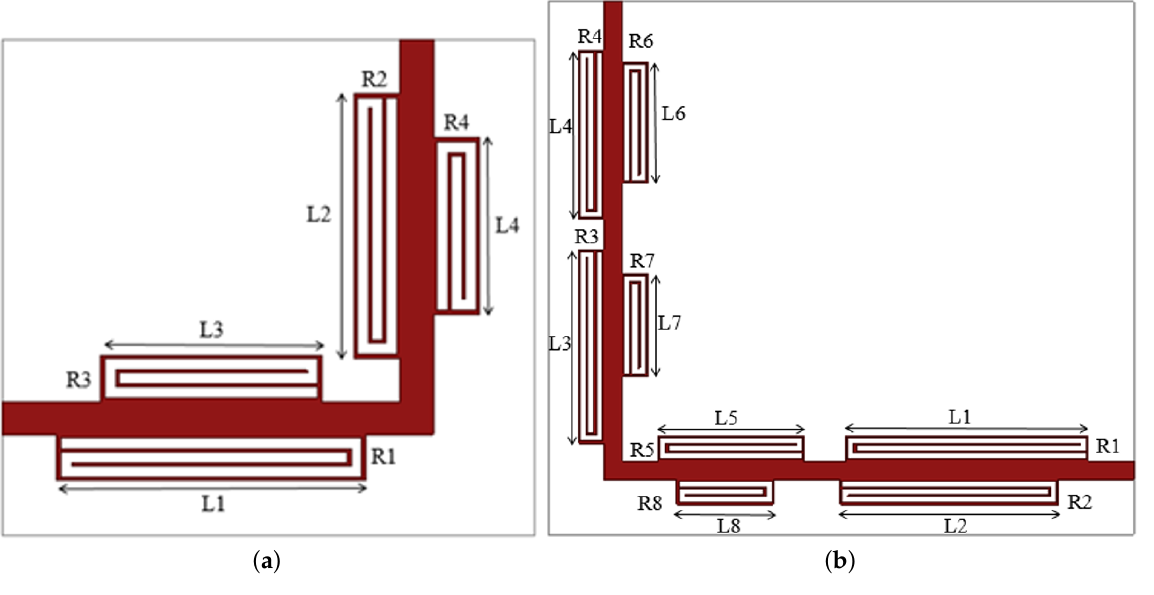
Figure 5. ( a ) Geometry of RFID tag resonator 4 bit ( b ) 8